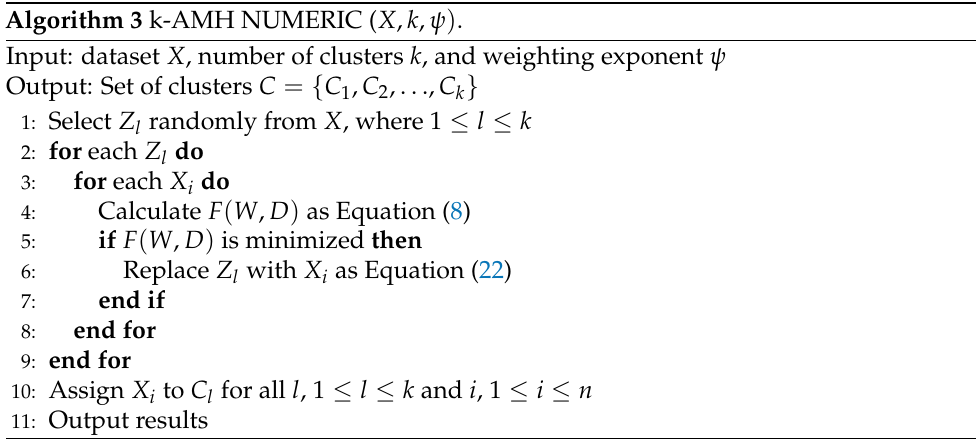
Algorithm 3 k-AMH NUMERIC ( X , k , ψ )